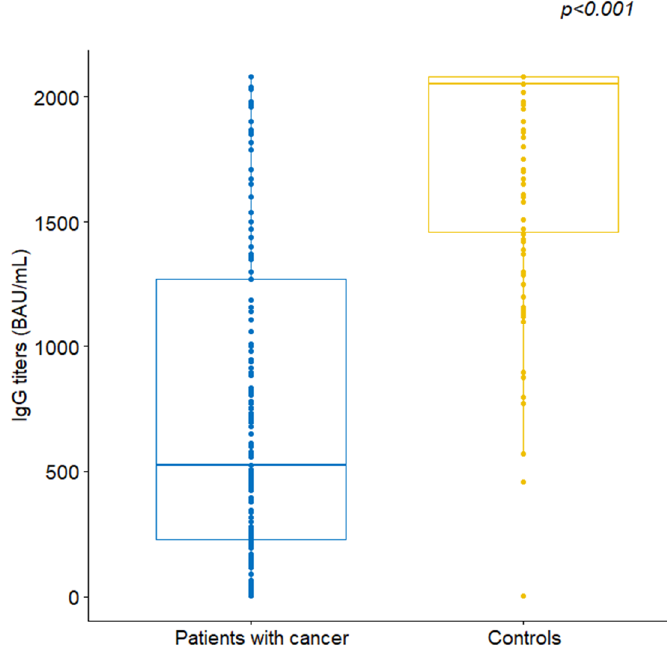
Figure 2. Comparison of anti-SARS-CoV-2 spike IgG antibodies between patients and controls. Among cancer patients, a significant association was identified between IgG titers and smoking status (Kruskal–Wallis p = 0.017). Post-hoc analysis revealed that never smokers had significantly higher antibody titers compared to current smokers (median value 632 versus 409.5, Wilcoxon rank-sum p = 0.006, Figure 3A). Additionally, female patients presented with higher antibody titers compared to males (median value 665 ver- sus 456, p = 0.022, Figure 3B). Higher antibody titers were also observed for PS 0 patients compared to those with PS 1 (median value 560 versus 253.5, p = 0.029, Figure 3C).